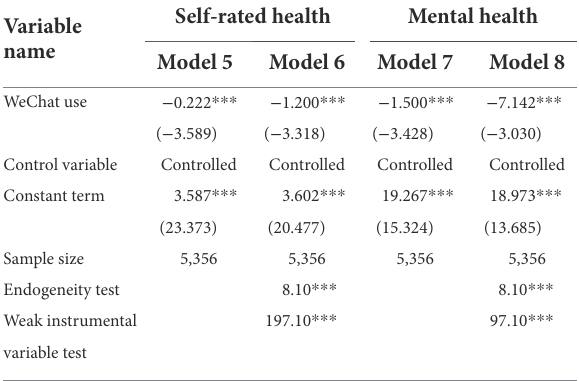
TABLE 4 Effects of WeChat use on the subjective health of older adults (only those who use WeChat Moments; OLS, two-stage least squares; China Health and Retirement Longitudinal Study, China,